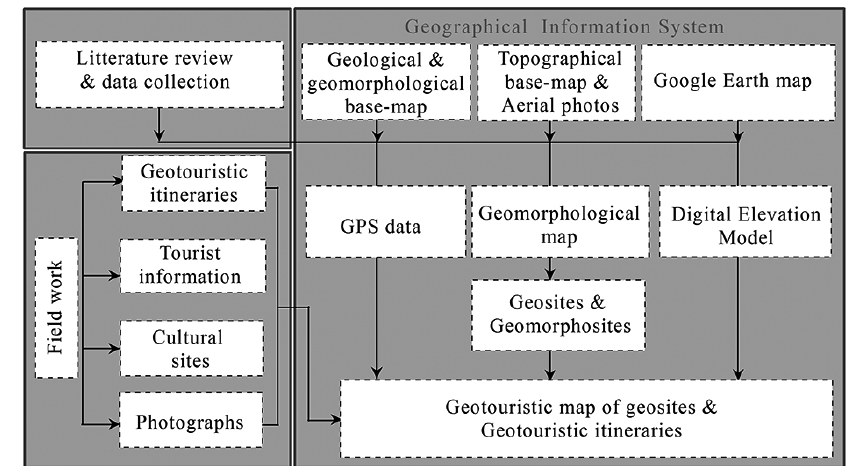
Fig. 3. Flow chart of used